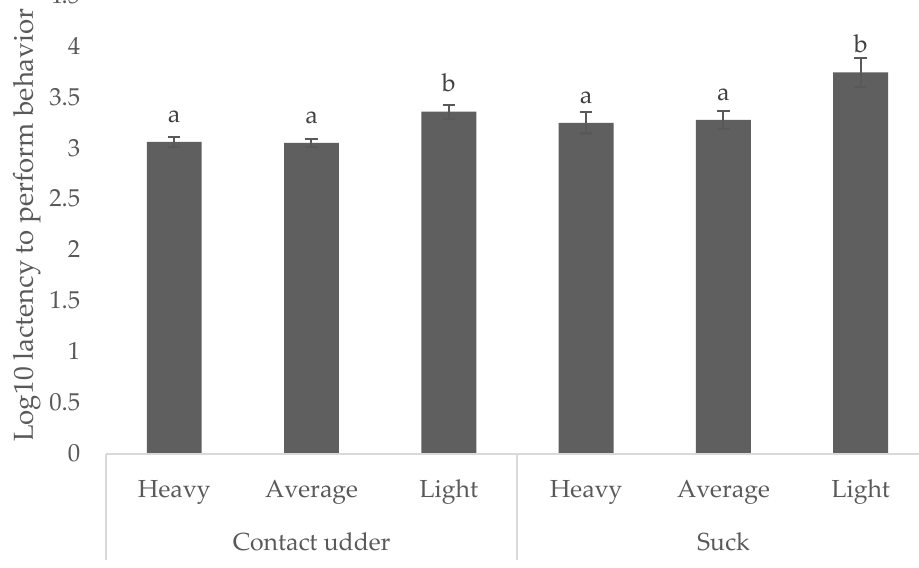
Figure 3. Mean ± s.e.m log 10 latency to contact the sow’s udder and successfully suck for piglets classed as heavy (>1.8 kg), average (0.8 to 1.8 kg), and light (<0.8 kg). a,b Means within birth order not having the same superscript are significantly different ( p < 0.05).